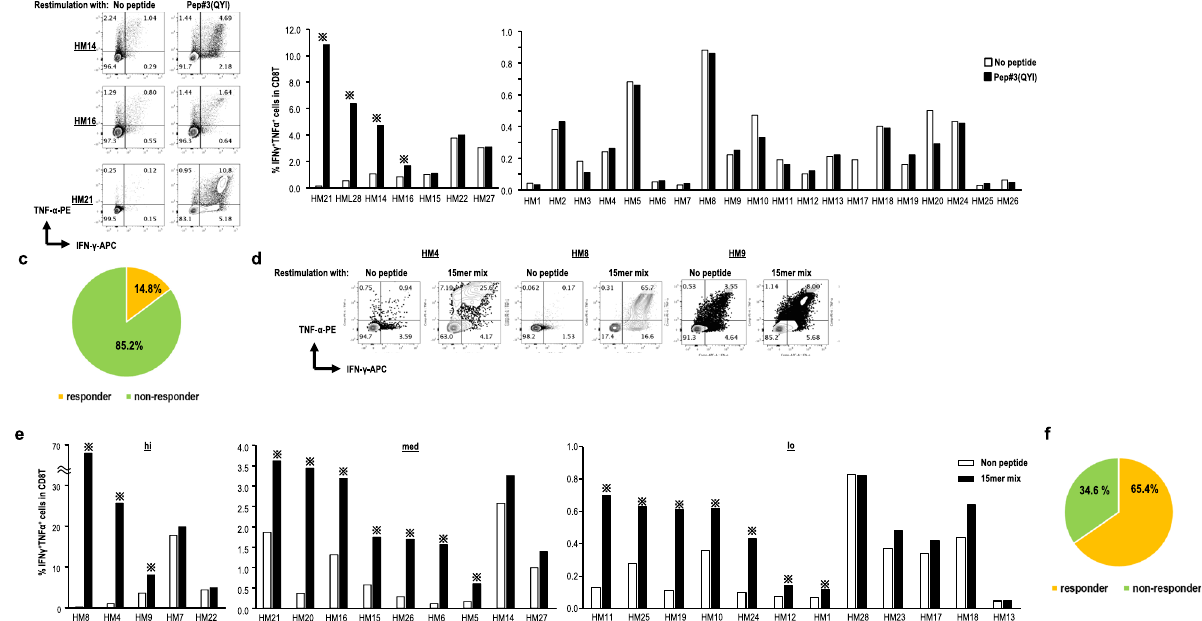
Fig. 5 SARS-CoV-2-speci fi c CD8 + T cell response in HLA-A*24:02-positive patients with hematological malignancy (HM). a – c Sorted CD8 + T cells from HLA-A*24:02-positive patients with HM were cultured with irradiated autologous PBMCs pulsed with SARS-CoV-2 Pep#3(QYI). The peptide- speci fi c CD8 + T cells were assessed by the frequency of IFN- γ + TNF- α + CD8 + T cells by an ICS assay on day 14. Flow cytometry data are from representative donors (HM14, 16, and 21) ( a ). The frequency of IFN- γ + TNF- α + CD8 + T cells is summarized ( n = 27) ( b ). Pie chart representing the proportions of responders or non-responders against Pep#3(QYI) in patients with HM ( c ) . d – f PBMCs from patients with HM were cultured in the presence of a 15-mer peptide mix. Two weeks later, the cultured cells were restimulated with or without the mix for 16 h in the presence of monensin and brefeldin. The frequency of IFN- γ + TNF- α + CD8 + T cells was measured after gating the CD8 + T cells by an ICS assay at day 14. Flow cytometry data are from representative donors (HM4, 8, and 9) ( d ). The frequency of IFN- γ + TNF- α + CD8 + T cells is summarized ( n = 26) ( e ). ※ responder (>1.5 fold change (restimulation + /restimulation − ). Pie chart representing the proportions of responders or non-responders against the 15-mer peptide mix in patients with HM ( f